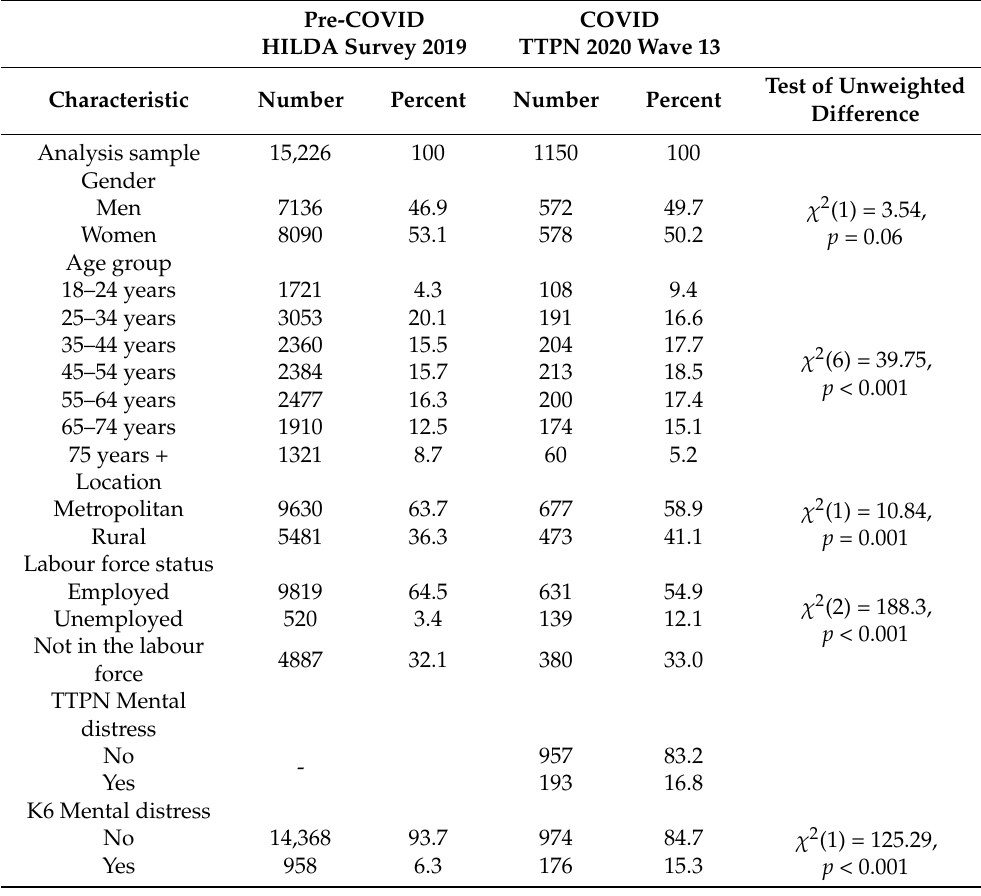
Table 1. Unweighted characteristics of analysis sample from the 2019 wave of the Household Income and Labour Dynamics in Australia (HILDA) Survey and wave 13 of the Taking the Pulse of the Nation (TTPN)